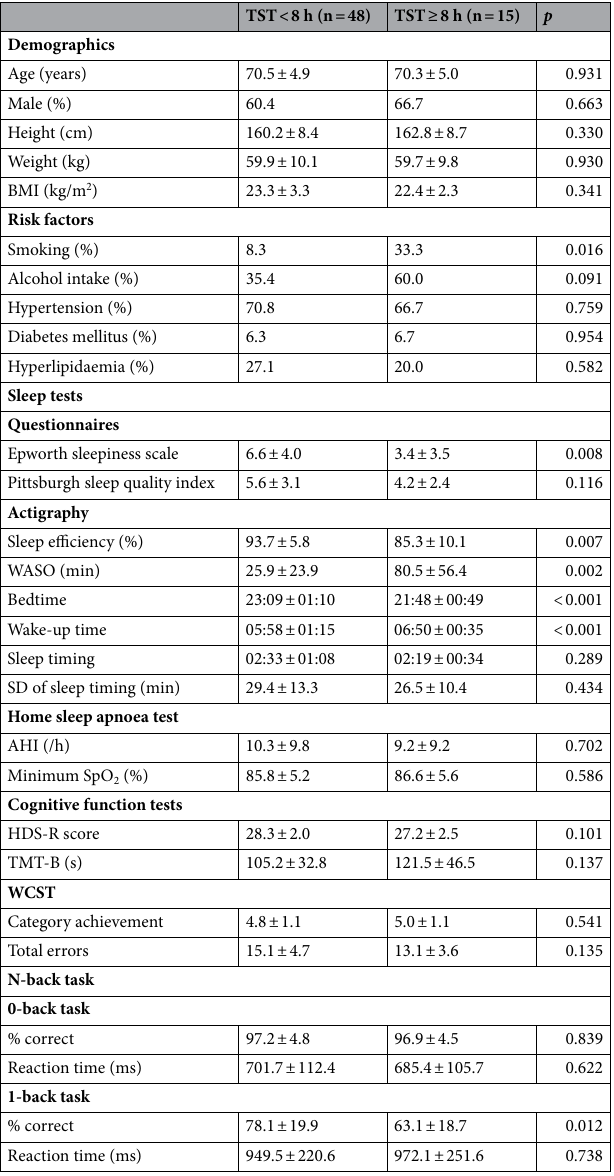
Table 3. Comparison of demographic/sleep parameters and cognitive function by TST. Data are expressed as the mean ± standard deviation. TST total sleep time, BMI body mass index, WASO wake after sleep onset, SD standard deviation, AHI apnoea–hypopnea index, HDS‑R revised Hasegawa’s dementia scale, TMT‑B trail making test B, WCST Wisconsin card sorting